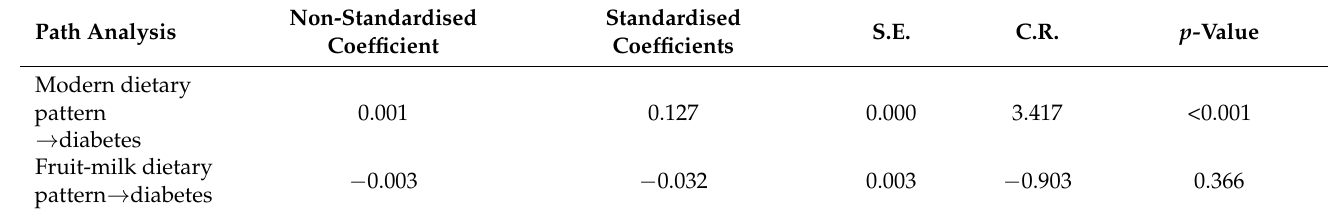
Figure 4. Final structural models. The path standardised coefficients of variables are presented on pathways. RMSEA = 0.068, GFI =0.913, ACFI = 0.891, PGFI= 0.727 and PNFI = 0.315. e, error. Table 3. Parameter Estimates from the SEqM of dietary patterns and high blood glucose among adults.